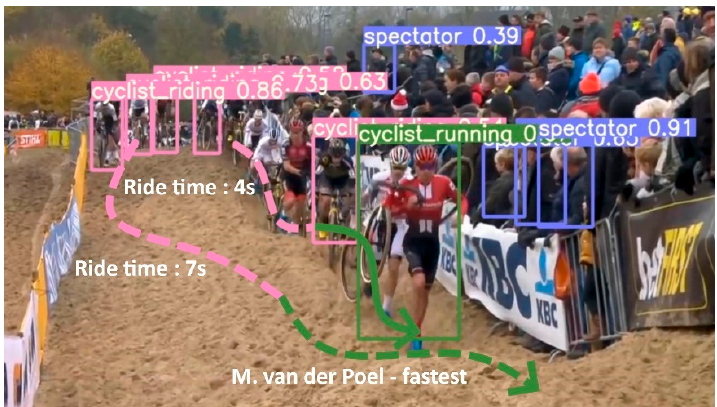
Figure 6. Confusion matrix and precision recall curve for the rider mode detector. As can be seen, the green line of spectators is performing significantly worse than the other classes.